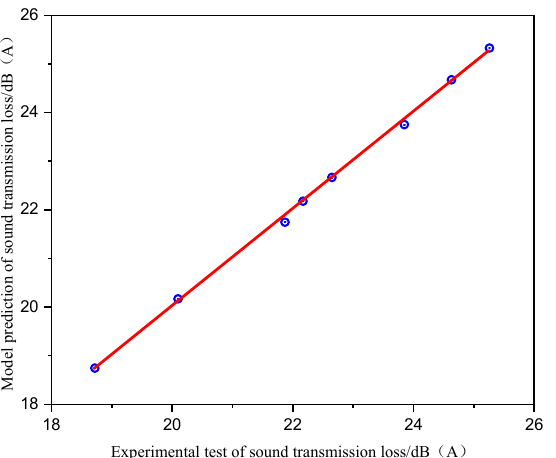
Figure 4. Comparison between the predicted and experimental values of the mathematical model for the rapid calculation of sound insulation.